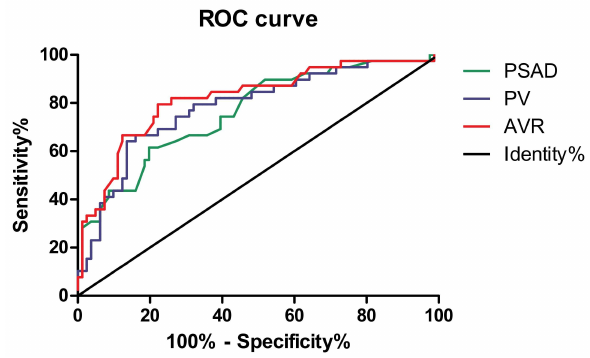
TPSA, total prostate specific antigen; PSAD, prostate specific antigen density; PV, prostate volume; (F/T)PSA, free/total prostate specific antigen; AVR, ratio of age to volume; PSA-AV, prostate specific antigen age volume score.